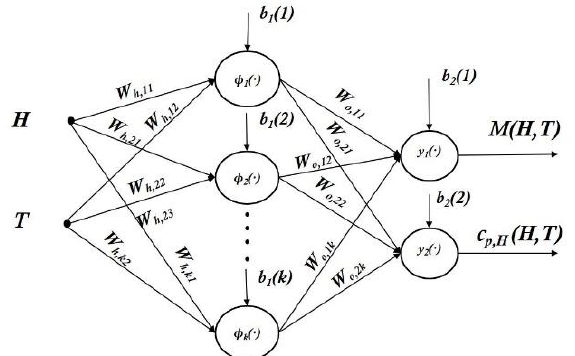
Figure 1. The adopted structure of the ANN. The magnetic field, in T , and the absolute temperature, in K, are the inputs of the ANN. The model provides the values of magnetisation, in A / m, and specific heat, in J / kgK, at the given magnetic field and absolute temperature. The subscript h refers to the synaptic weights between the hidden and the input layer. The subscript o refers to the synaptic weights between the output and the hidden layer. The index and the subscript k refer to the k -th neuron of the hidden layer.